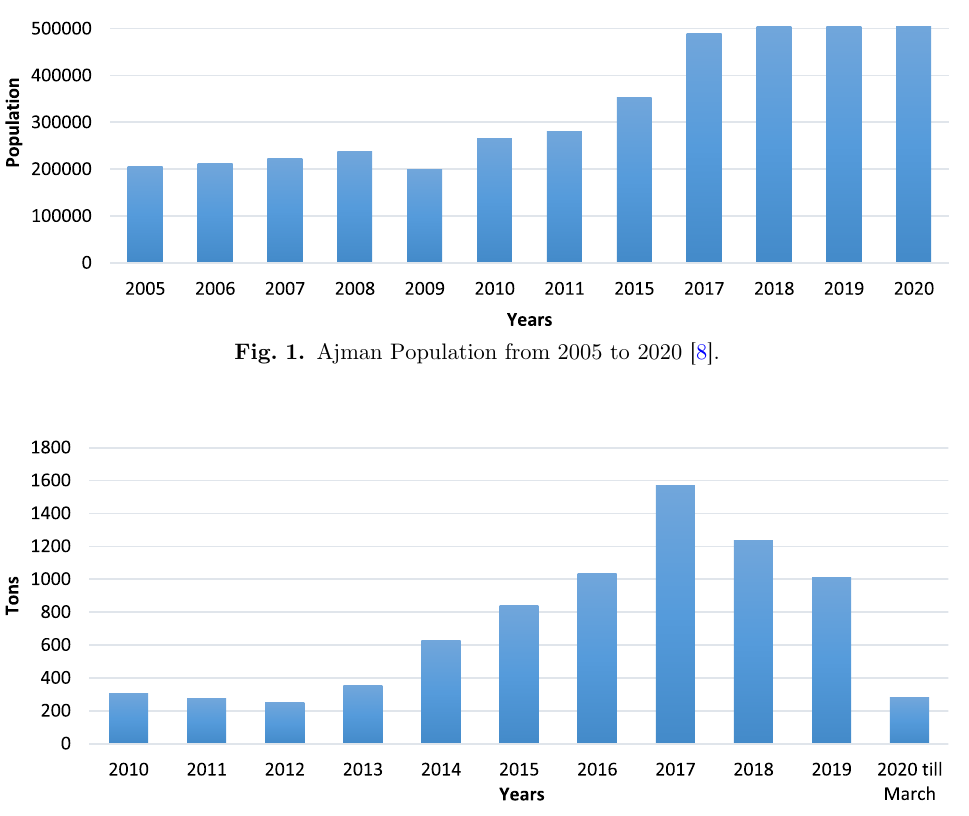
Fig. 2. The quantity of non-hazardous waste (Ajman (cid:1) UAE)